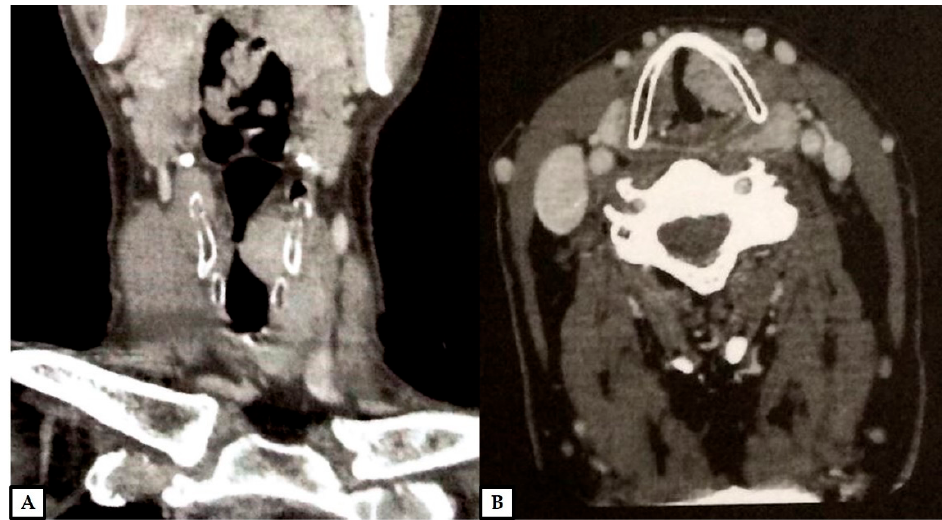
Figure 1. A 66-year-old man presented with a previous diagnosis of granular cell tumor of the left vocal cord on an incisional biopsy performed at another hospital. Contrast-enhanced computed tomography revealed a soft tissue mass of 2.8 × 2.5 × 1.1 cm of the left vocal cord, with transglottic extension, spreading to the supraglottis, subglottis, paraglottic space and the anterior commissure, causing partial obstruction of the laryngeal lumen; no infiltration of the cartilage was evident (computed tomography scans; ( A ): coronal plane, ( B ): axial plane; previously unpublished, original photos).